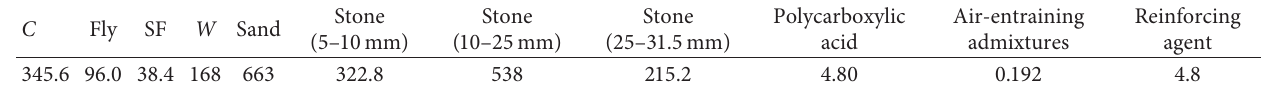
Table 10: The optimal mix ratio of C40 pavement concrete (kg/m 3